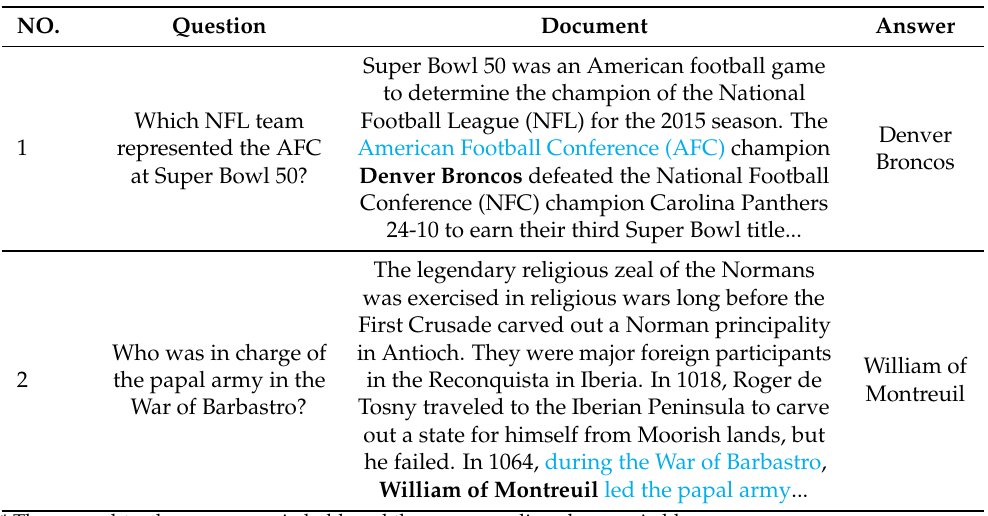
Table 1. Samples from the SQuAD dataset. An extractive QA model needs to understand the natural language question and the evidence in the document to find the answer span from the document ∗ .